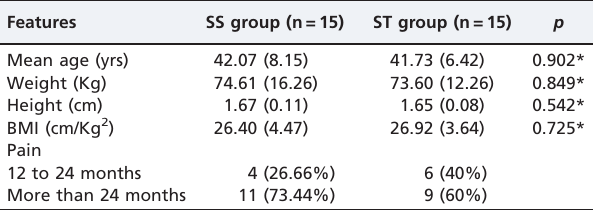
Table 2 - Patient’s clinical and demographic data, according to group.